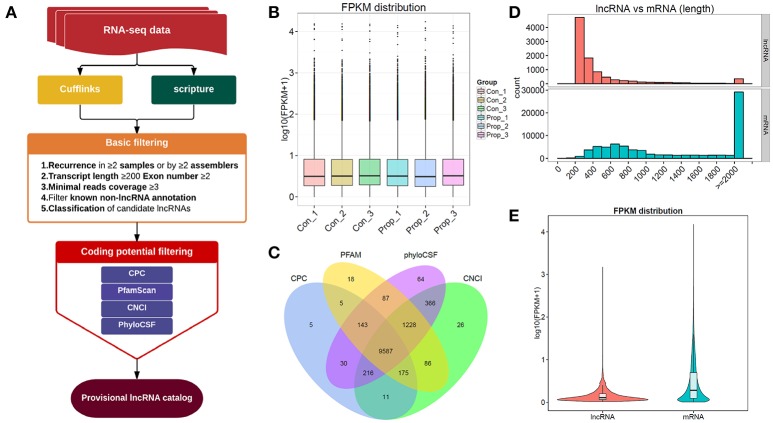
The comprehensive evaluation and screening of candidate lncRNAs. (A). The main workflow for screening provisional lncRNAs; (B). The box plots of FPKM distribution in different groups, showing no significant differences between the control and propofol groups; (C). The Venn diagram of the coding potential of screened transcripts using CNCI, CPC, PFAM, and phyloCSF, 9587 transcripts were predicted to have no coding potential by all of the four methods; (D) The full length of mRNAs is longer than lncRNAs; (E) The violet plots of expression levels of lncRNAs and mRNAs.